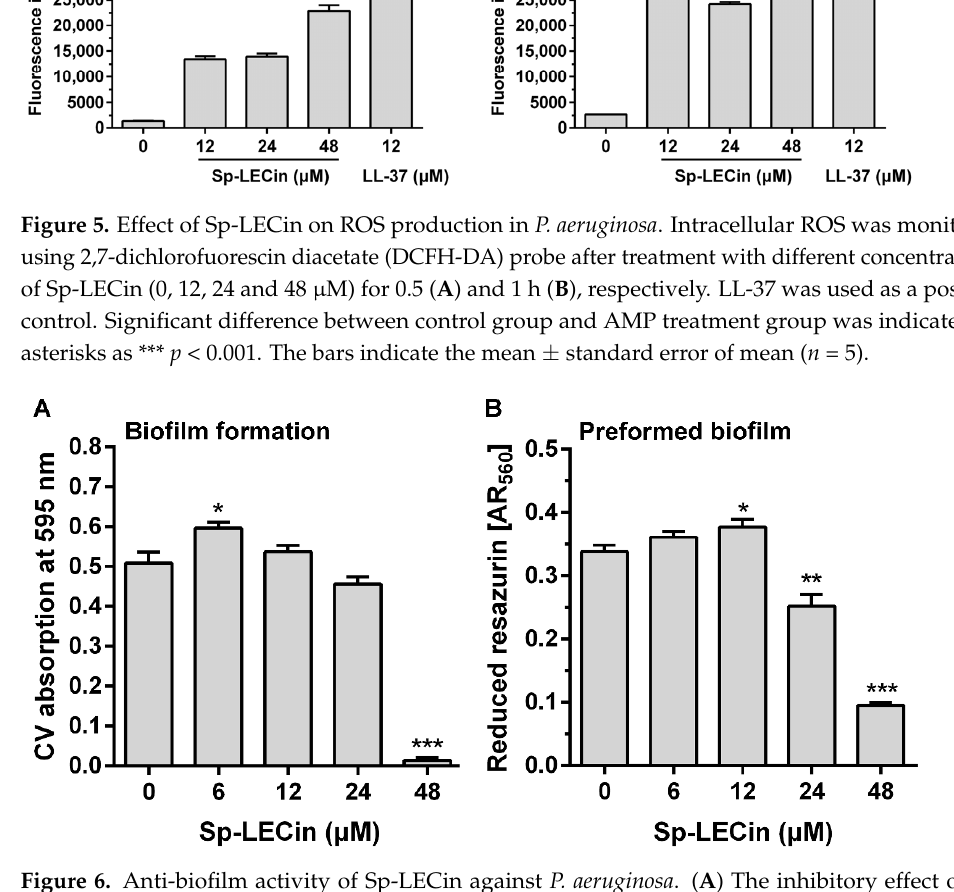
Figure 6. Anti-biofilm activity of Sp-LECin against P. aeruginosa . ( A ) The inhibitory effect of Sp- LECin on the formation of P. aeruginosa biofilm. The biofilm mass was quantified by crystal violet (CV) and the absorbance at 595 nm was measured. ( B ) The inhibitory effect of Sp-LECin against the preformed biofilm of P. aeruginosa . The amount of reduced resazurin and the residual amount of oxidized resazurin was determined by measuring at the absorbance at 560 nm and 620 nm, respec- tively. The corrected A560 value (AR560) was calculated using the following formula: AR560 = A560 − (A620 × RO) and RO = AO560 / AO620, where A560 and A620 are sample absorbance and AO560 and AO620 are the absorbance of medium containing 0.1 mM resazurin. Significant difference be- tween control group and Sp-LECin treatment group was indicated by asterisks as * p < 0.05, ** p < 0.01 and *** p < 0.001. The bars indicate the mean ± standard error of mean ( n = 5).